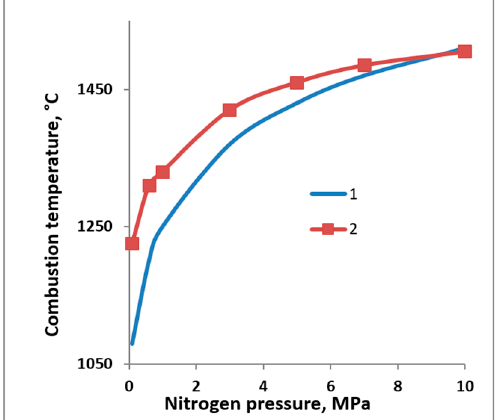
( a ) the impact of nitrogen pressure on the rate of chromium combustion and ( b ) nitrogen content in the product. 1—calcium-hydride process chromium; and 2—aluminothermic process chromium.